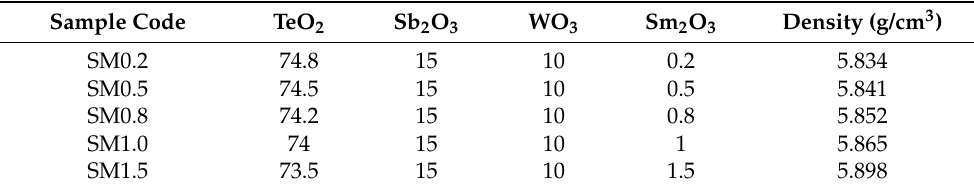
Table 1. Chemical compositions (mol%) and density values of HMO glasses.